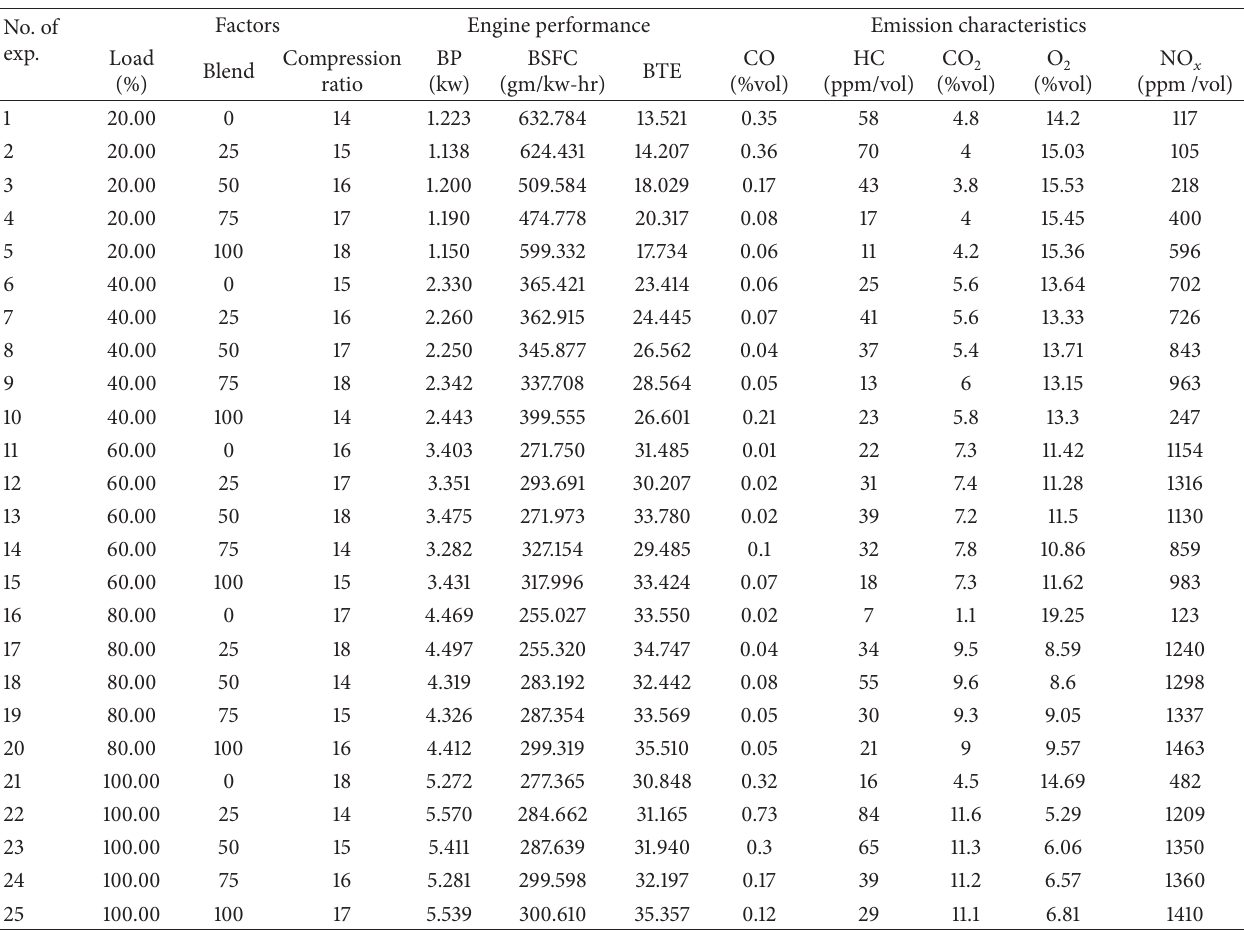
Table 4: Experimental results of engine performances and